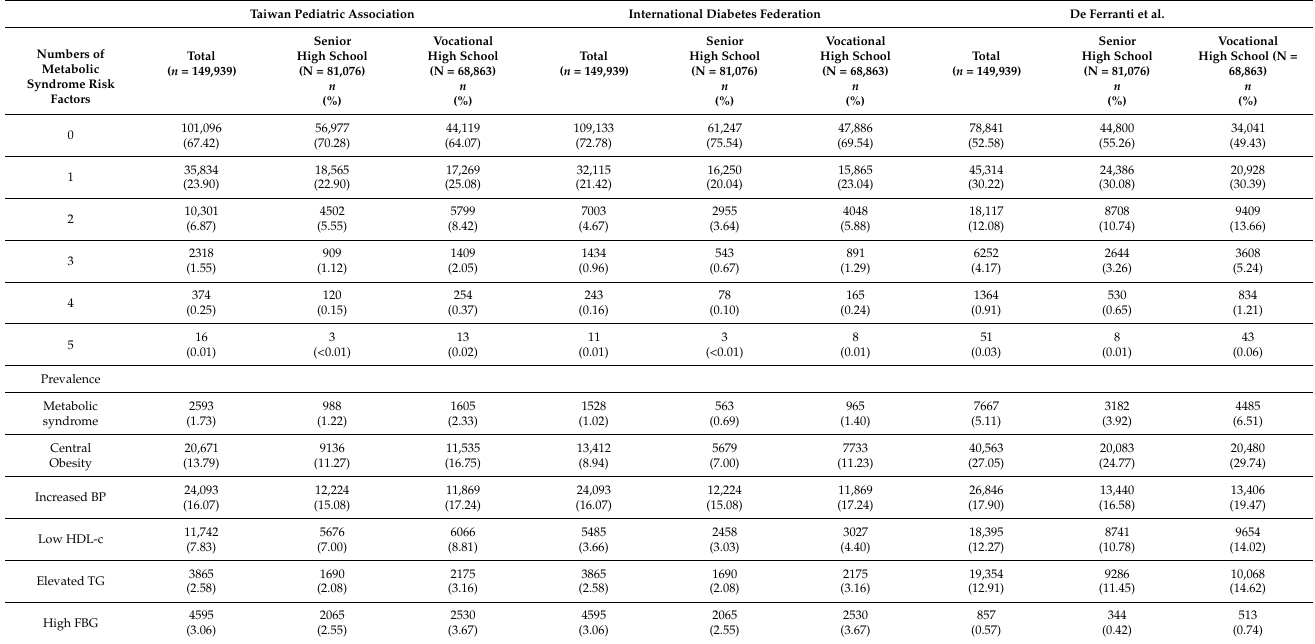
Table 3. Distribution and prevalence of metabolic syndrome risk factors for senior and vocational high school students. TaiwanPediatricAssociation InternationalDiabetesFederation DeFerrantietal.